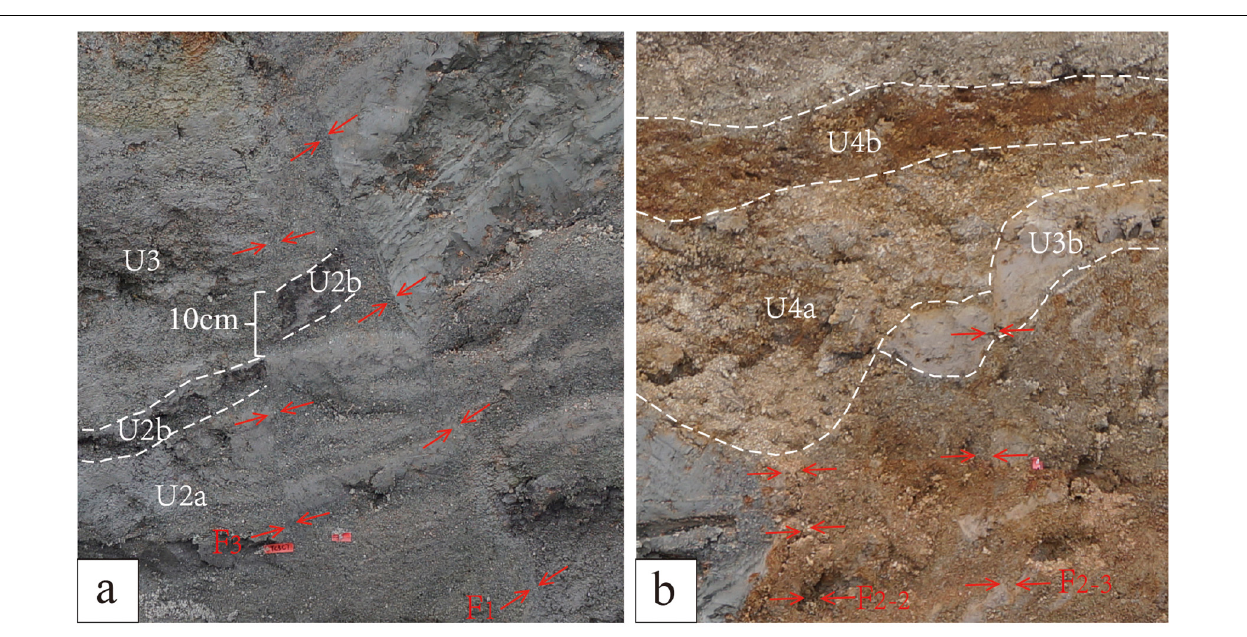
FIGURE 11 | Local enlarged photographs of the northwestern wall of trench TC2: (a) marker unit U2b-1, which was displaced by F 3 during Event II, and (b) unit U3b, which was displaced by F 2 - 3 and covered by unit U4 during Event